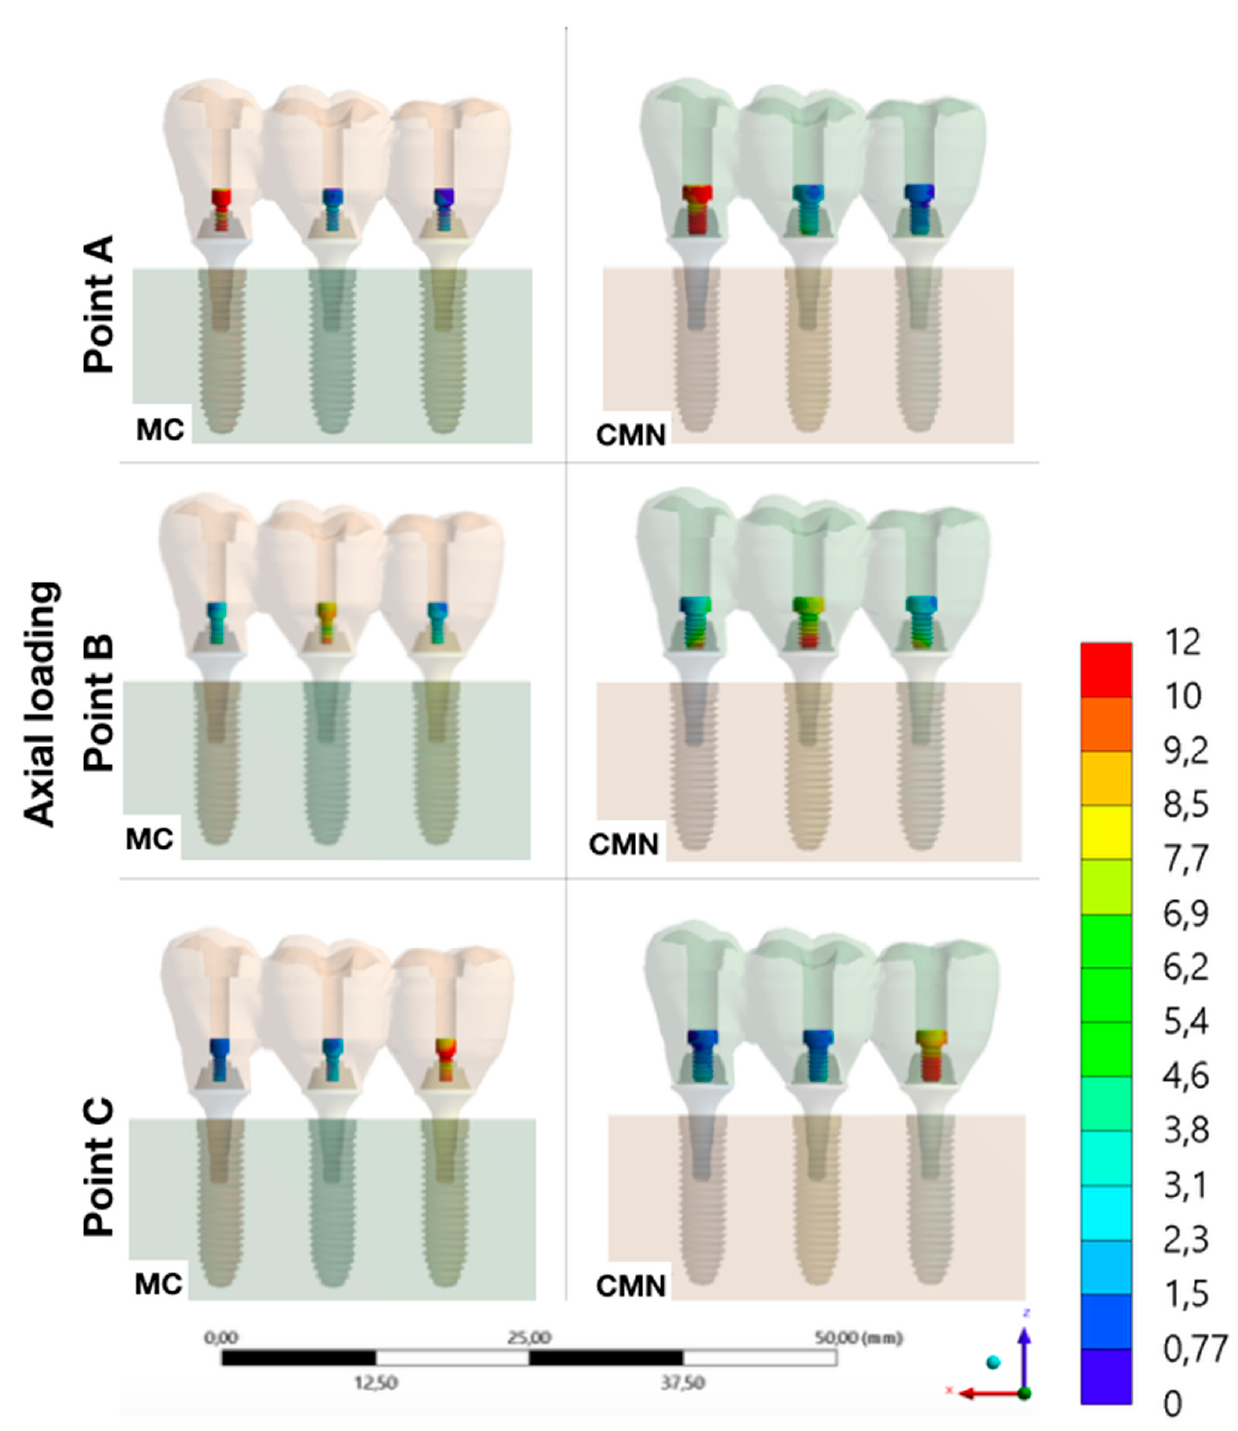
Figure 8. Maximum principal stress (MPa) at the screws for the load application at points A, B, and C (CMN and MC groups).